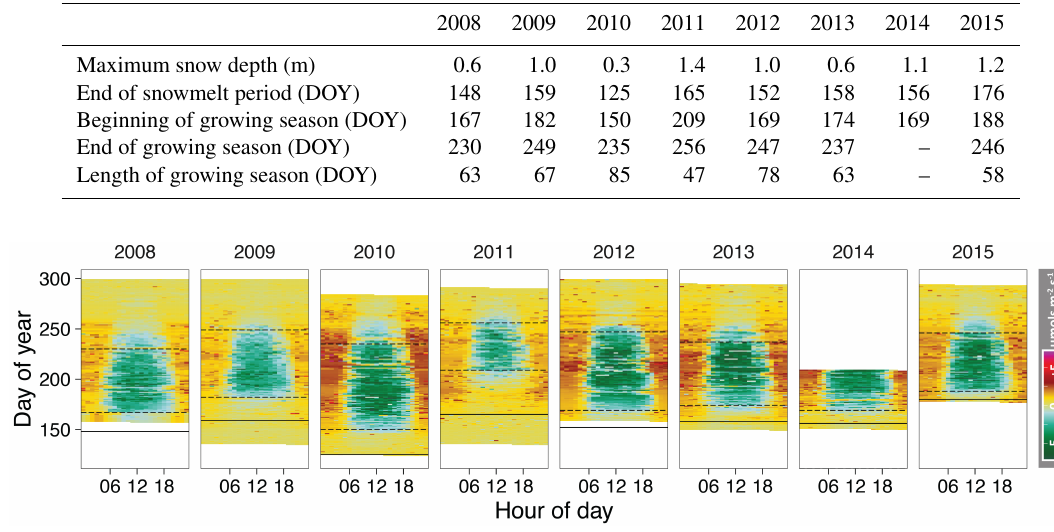
Figure 3. Time series of gap-filled NEE (2008–2015) based on autochamber data (2010–2013) and the MDS algorithm (from REddyProc). Green represents C uptake while the orange–dark-red denotes C release. The solid lines represent the end of the snowmelt period, while the area within the dashed lines represents the period between the start and the end of the growing